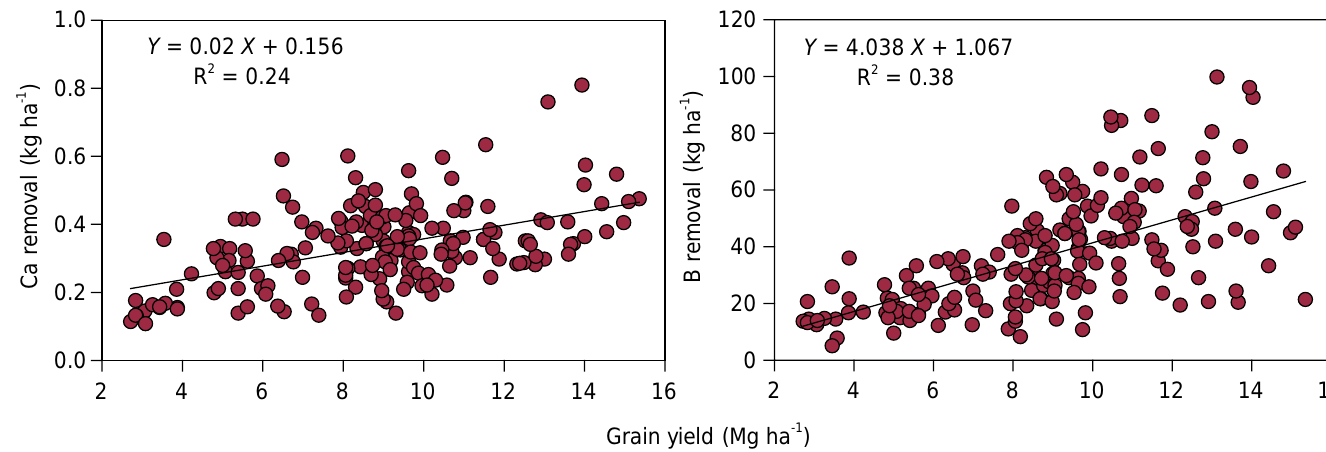
Figure 4. Removal of calcium and boron related to corn grain yield.